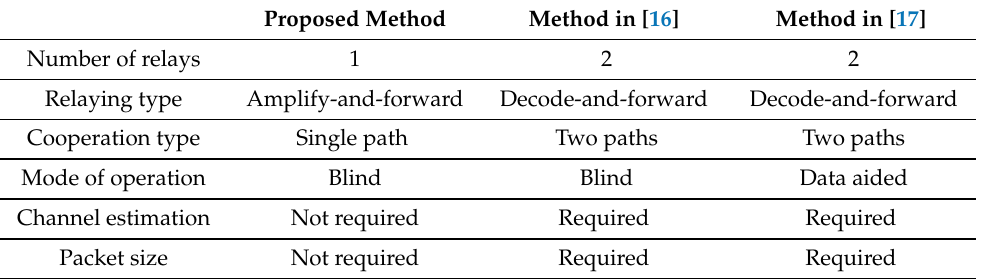
Table 1. Comparative analysis of our study and existing